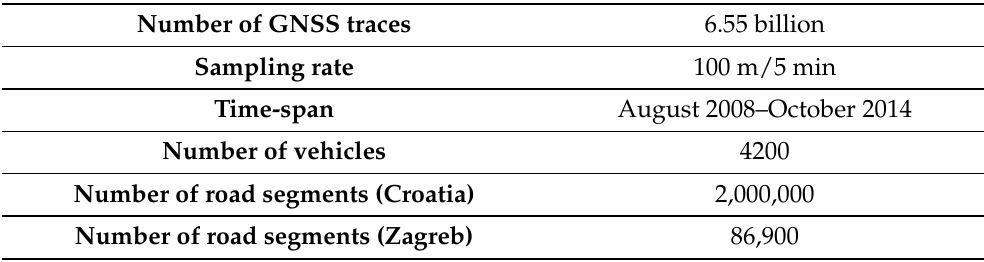
Figure 7. Result of the grid-based map segmentation and the data filtering process. Table 2. Data